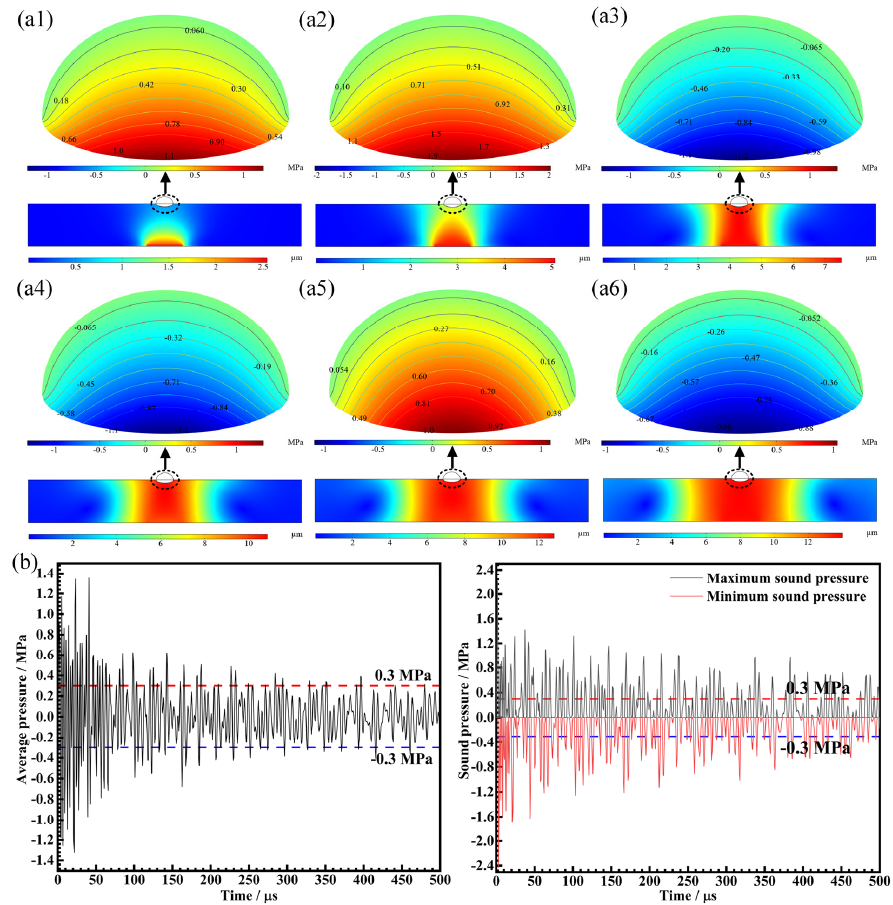
specific sound pressure amplitude, initial radius and ultrasonic frequency is calculated as Figure 15. Simulation results of sound pressure in the molten pool: ( a ) sound pressure and vibration Figure 15. Simulation results of sound pressure in the molten pool: ( a ) sound pressure and vibration shown in Figure 16. The horizontal coordinate is the ratio of time to ultrasound period amplitude at 1 us to 6 us with 1 us time interval; ( b ) average, maximum and minimum sound pres- and the vertical coordinate is the ratio of the real-time radius of the cavitation bubble to amplitude at 1 us to 6 us with 1 us time interval; ( b ) average, maximum and minimum sound sures in the molten pool; 1–6 represents each microsecond from 1 us to 6 us. the initial radius, showing the variation of the cavitation bubble radius over ten ultra- pressures in the molten pool; 1–6 represents each microsecond from 1 us to 6 us. sound periods. The Rayleigh–Plesset equation is solved using the differential equation interface in COMSOL Multiphysics software, and the evolution law of the cavitation bubble under